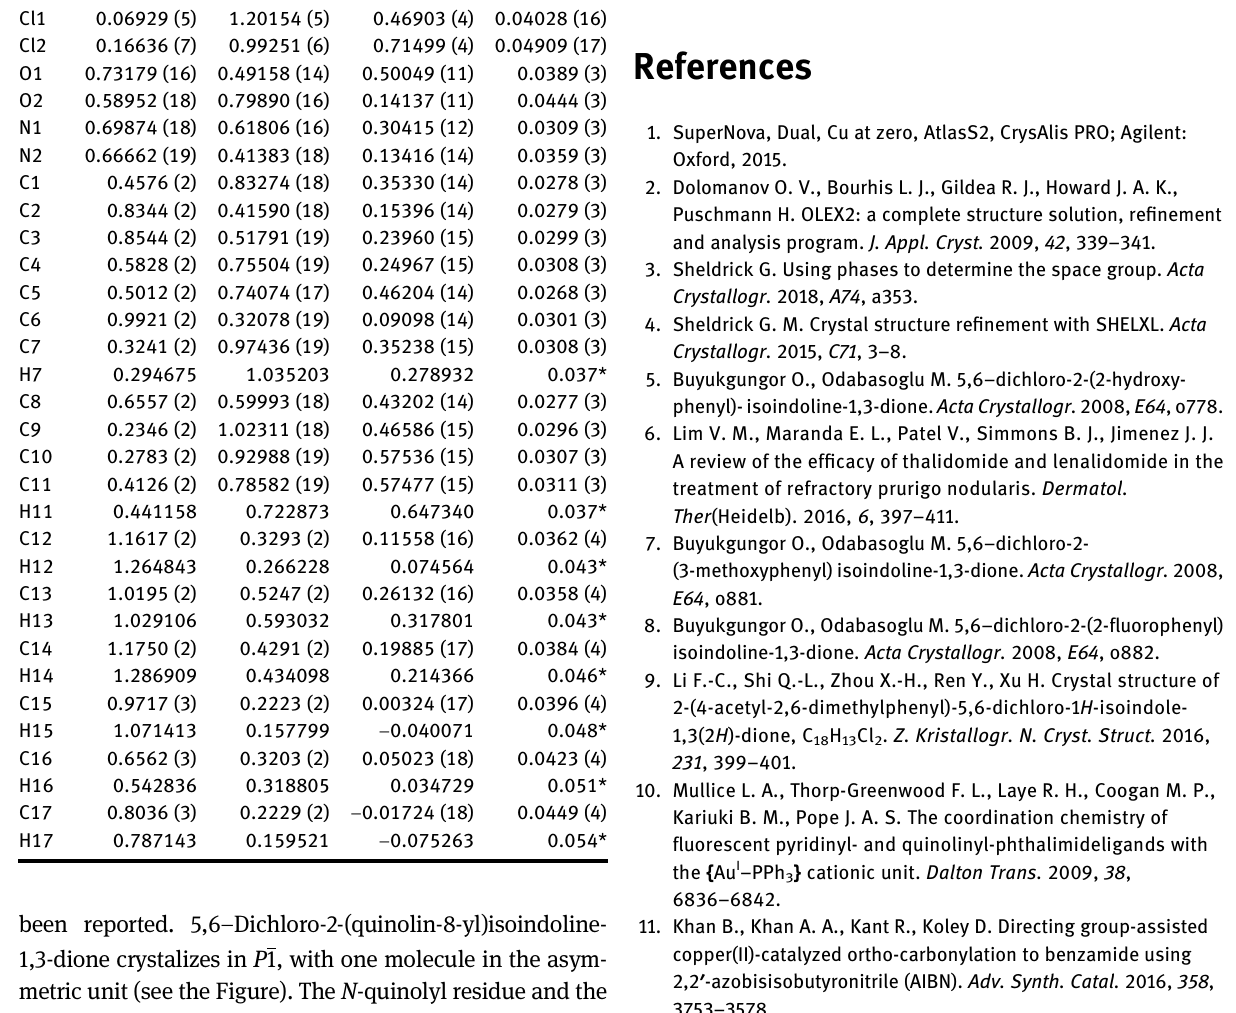
hydrogen bonds and van der Waals interactions.